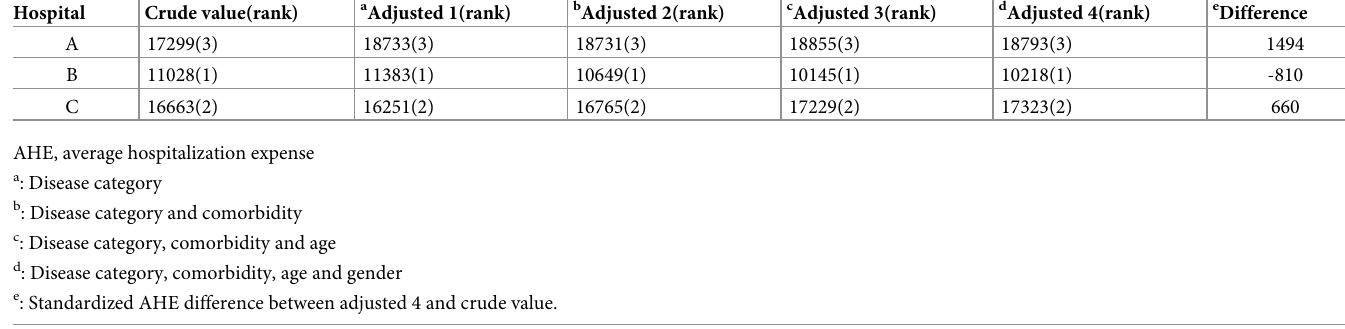
Table 10. Results of standardized AHE among three hospitals based on confounding factor stratification(CNY). Hospital Crude